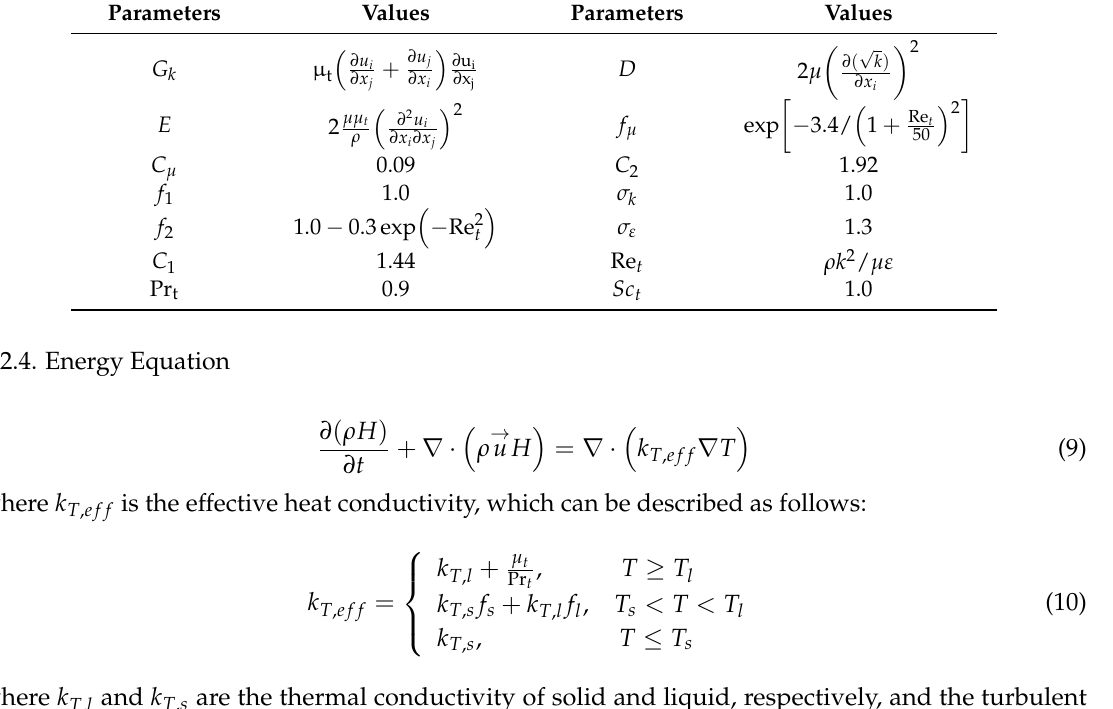
Table 1. Coefficients and empirical constants used for the low-Reynolds number model. Parameters